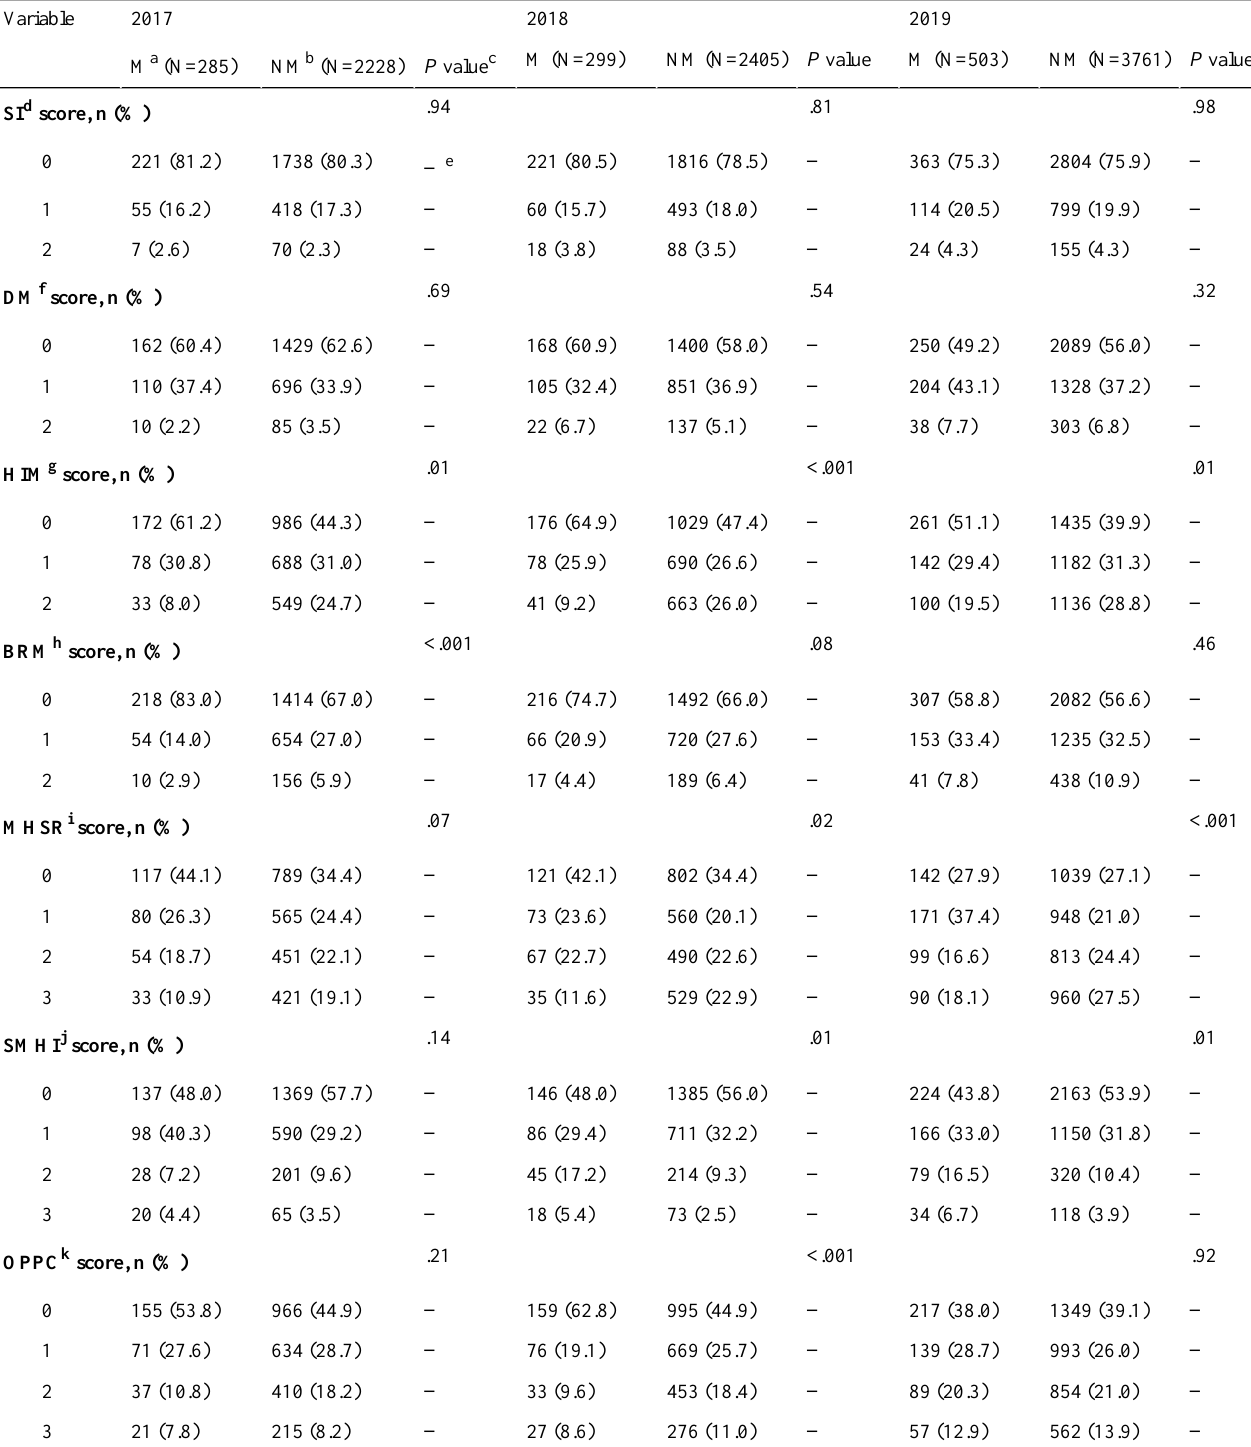
Table 2. The frequency and weighted prevalence of eHealth tools adoption among Medicaid and non-Medicaid populations from 2017 to 2019.